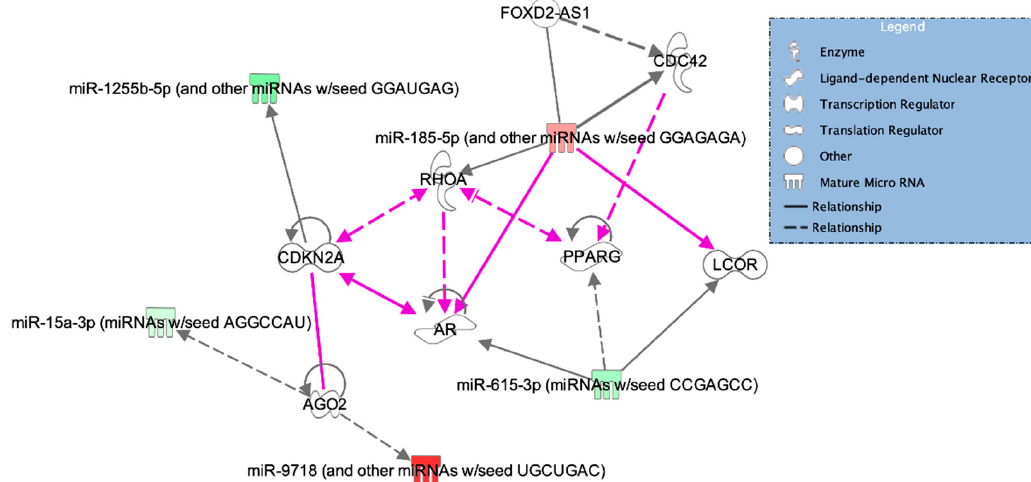
Figure 5. Graphical representation for the top 4 networks associated with differentially expressed miRNAs in severe BPD samples. Grey lines represent individual pathways, and pink lines indicate interactions among pathways. Full and dotted lines indicate direct and indirect relationships between molecules, respectively. miRNAs with higher expression in the severe BPD group are shown in shades of red, according to upregulation intensity. Similarly, miRNAs with lower expression in severe BPD are shown in shades of green. AGO2: argonaut RISC (RNA-induced silencing complex) catalytic component 2; CDKN2A: cyclin-dependent kinase inhibitor 2A; AR: androgen receptor; LCOR: ligand-dependent nuclear receptor corepressor; CDC42: cell division cycle 42; FOXD2-AS1: FOXD2 (forkhead box D2) adjacent opposite strand RNA 1; PPARG: peroxisome proliferator-activated receptor gamma; RHOA: Ras homolog family member A.